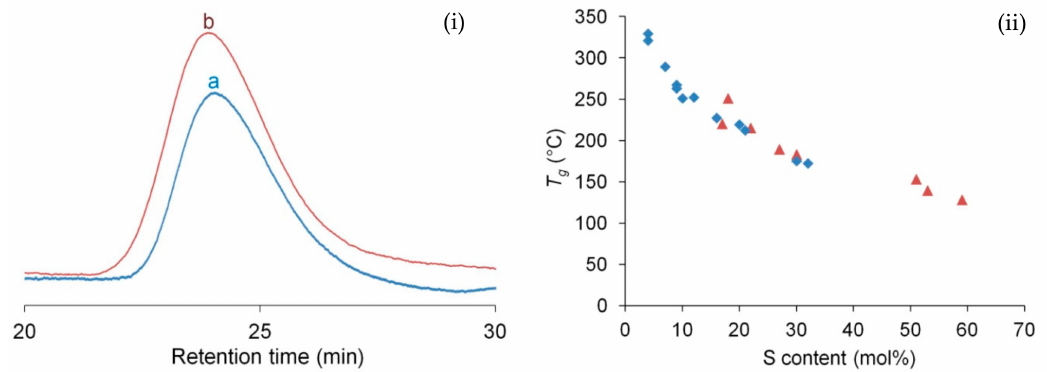
Figure 3. ( i ) GPC traces of N / S copolymers: a , Run 24; b , Run 25 ( ii ) S content versus T g plot obtained by Ni complexes: (cid:95) , MMAO; (cid:78) , B(C 6 F 5 ) 3 .